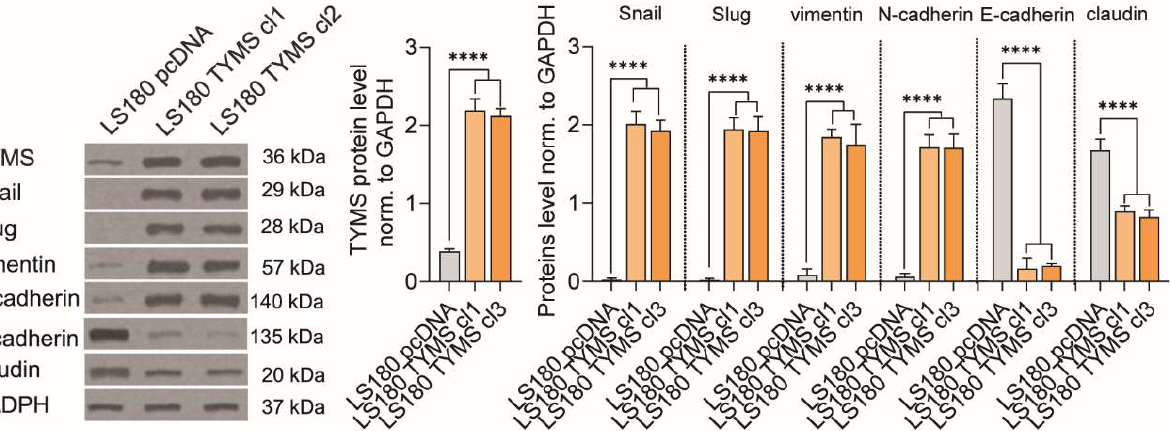
Figure 2. TYMS overexpression induced EMT in LS180 cells. TYMS protein level and EMT markers were measured by Western blot in TYMS overexpressing cells. Representative blots are shown, and graphs displaying the mean protein level normalized to GAPDH ± SD ( n = 3). ns—non-significant; **** p < 0.0001.